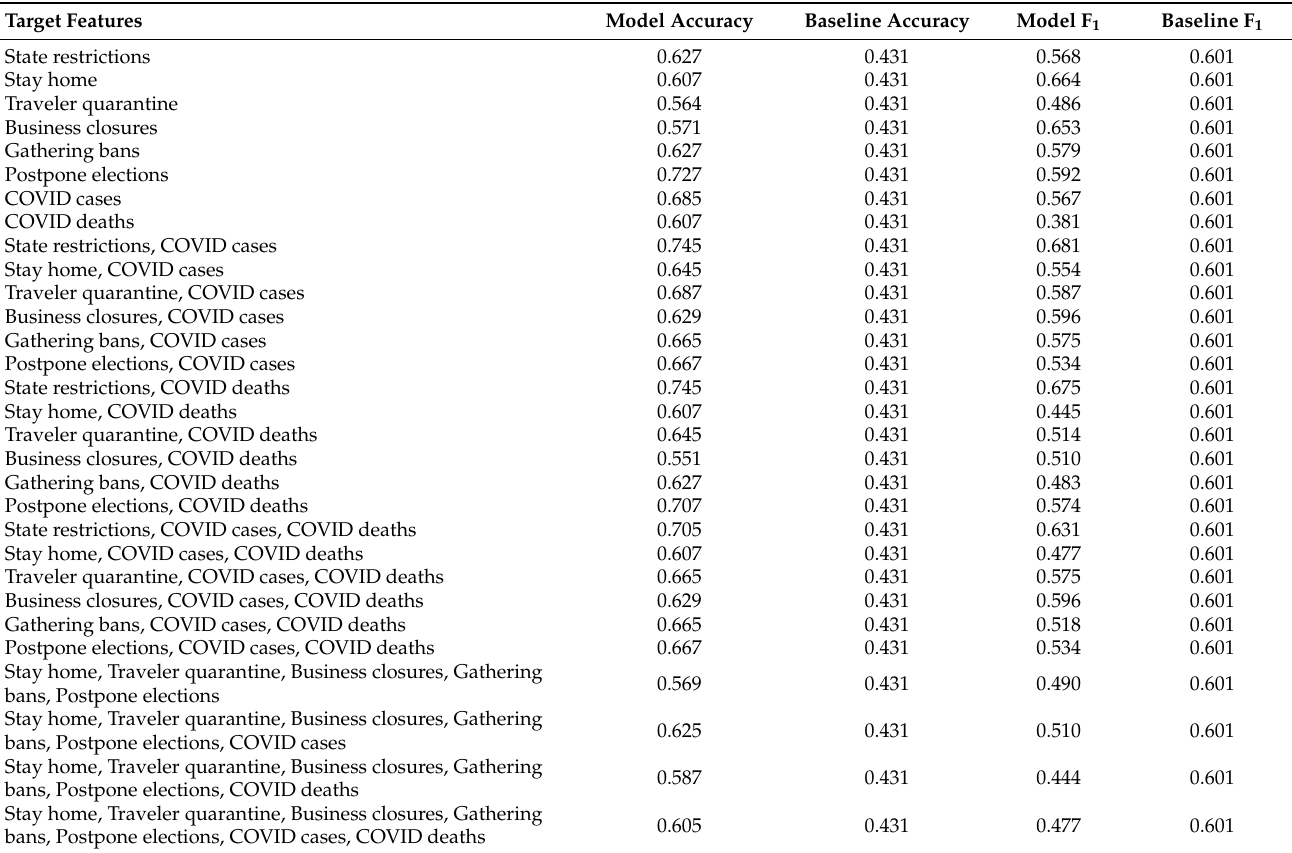
order determinants of the contraction outcomes in the real economic output, stay home orders, gathering bans, and traveler quarantines have only trivial predictive capability. Table 6. Predictive modeling of state policies and COVID-19 severity for forecasting real economic contraction in lo- cal